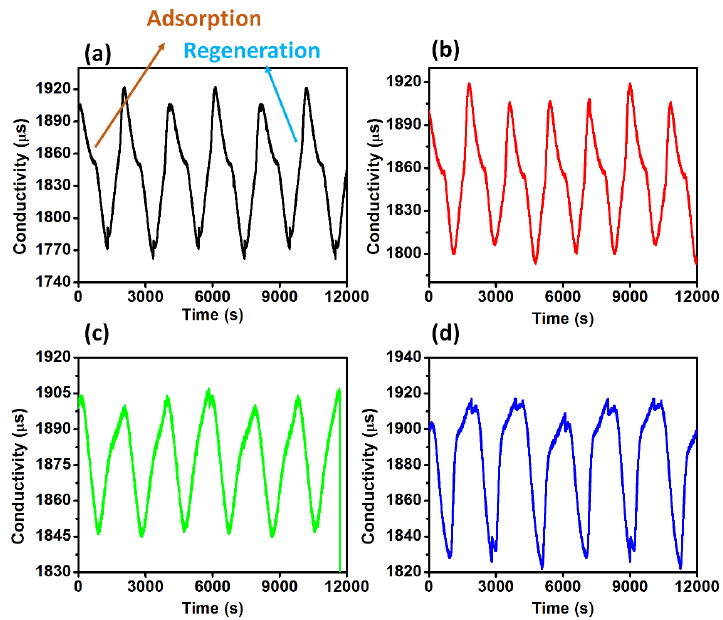
Figure 9. The change in conductivity of the NaCl water solution during the cyclic absorption and regeneration for the prepared electrode at PVDF concentration ( a ) 5%, ( b ) 7.5%, ( c ) 10%, and ( d ) 12.5%.